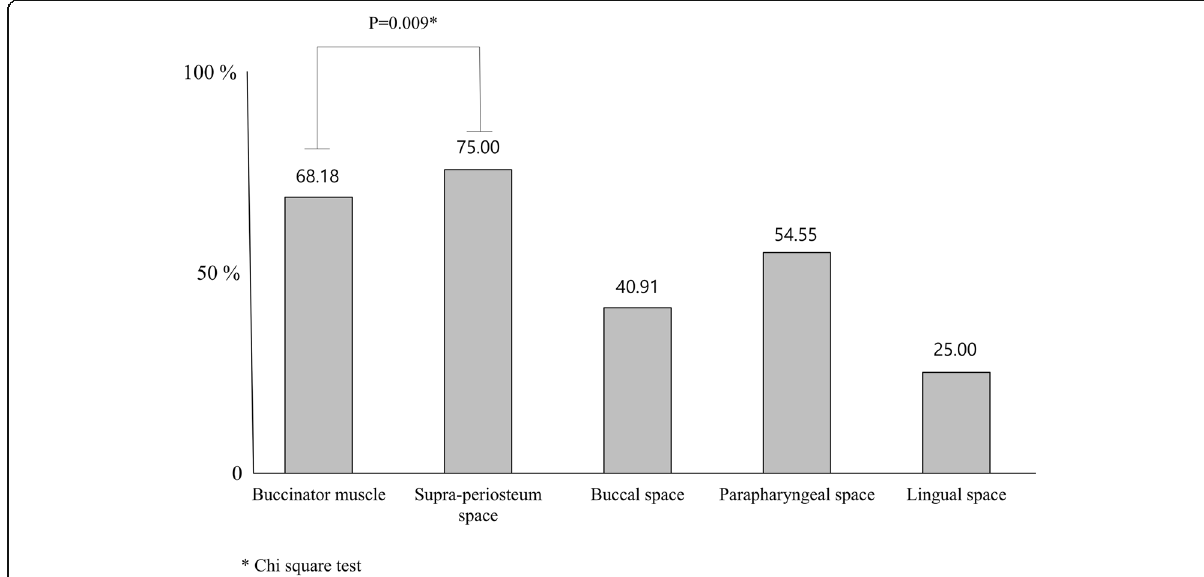
Fig. 4 Incidence of postoperative edema for each space. The incidence of buccinator muscle and supra-periosteum space showed a correlation according to a Chi-square test ( P = 0.028)